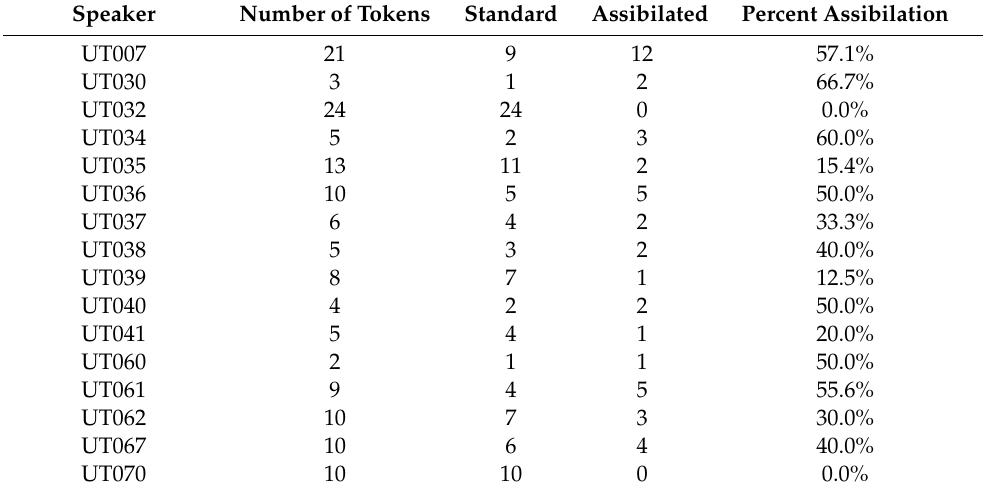
Table A1. Number and percentage of realizations of the standard and assibilated by individual